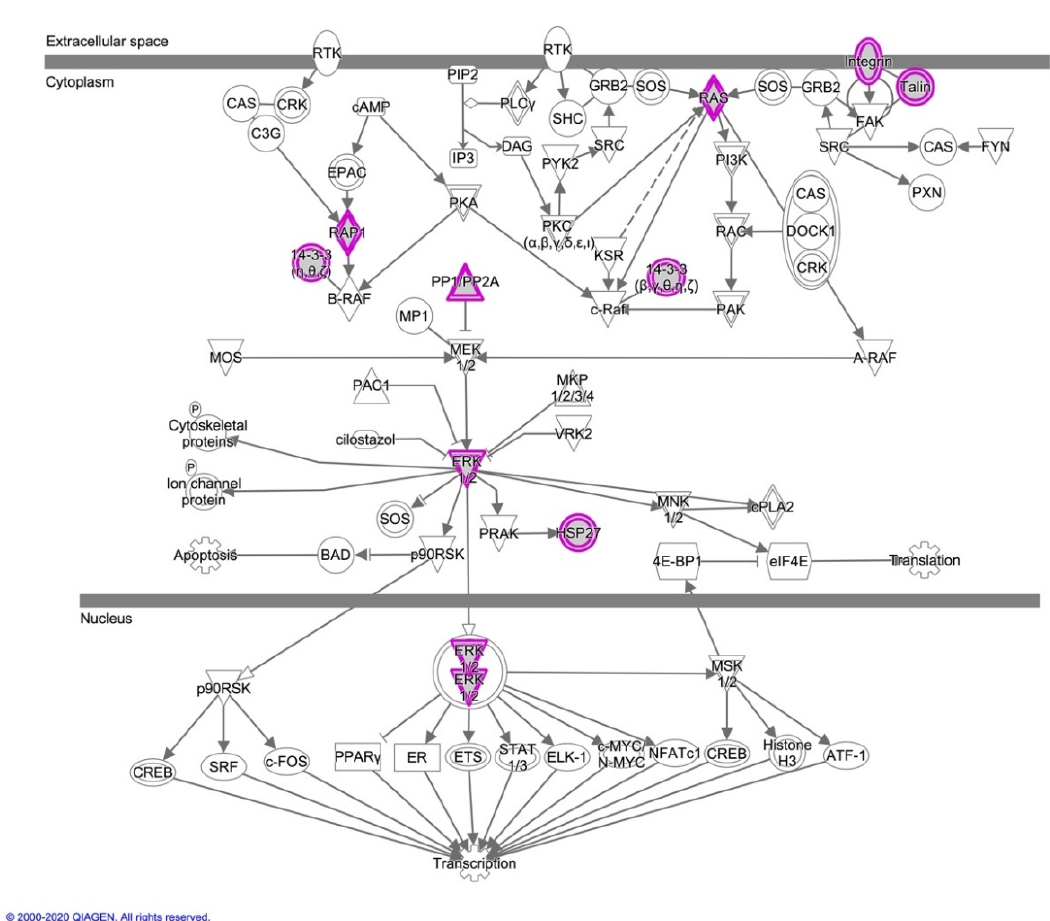
Figure 4. Common proteins identified in the three replicates of canine in vitro oviductal cell-derived extracellular vesicles that participate in the canonical pathway (CP) ERK/MAPK signaling. The Ingenuity Knowledge Base defines this CP. The grey molecules highlighted with pink were identified in three biological samples of canine in vitro oviductal cell-derived extracellular vesicles. The arrows represent the directionality of the interaction between molecules or a molecule and a bio-function. The vertical tip represents inhibition. The solid line is for direct interaction, and the dashed line is for indirect interaction.